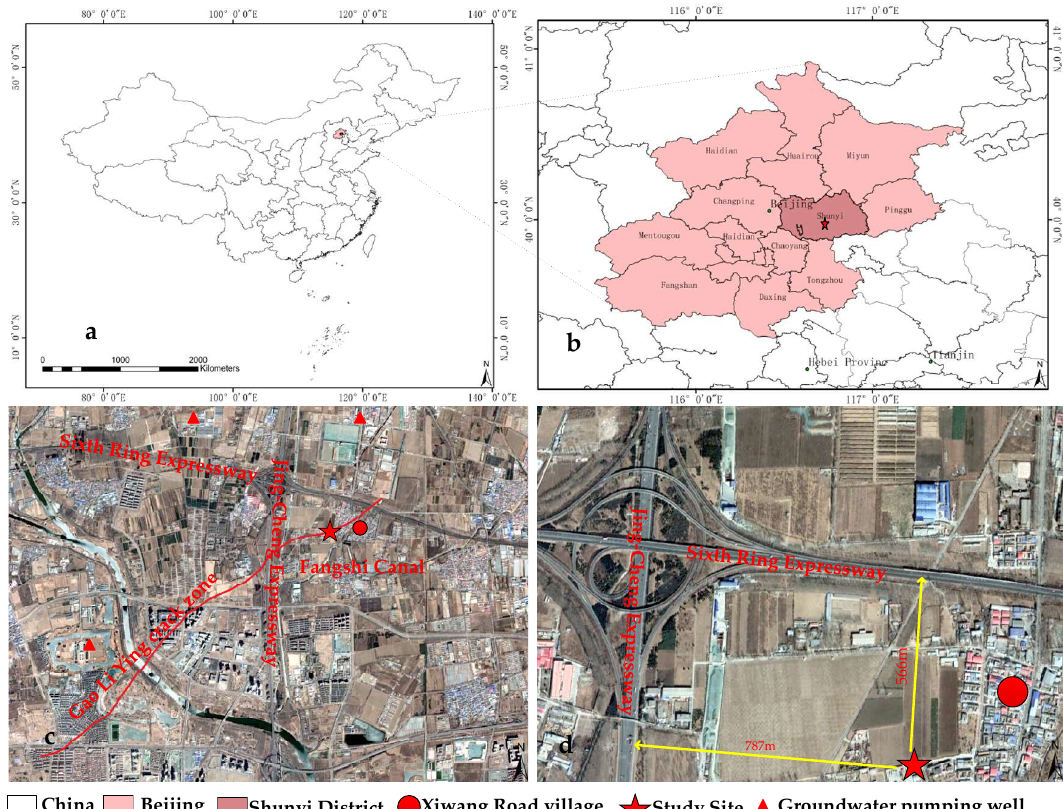
Figure 1. Location of the study site, ( a ) the study site in China, ( b ) the study site in Shunyi District of Beijing, ( c ) two expressways, a canal, three pumping wells and Gao Li Ying crack zone around the study site, ( d ) distances between two expressways and the study site.